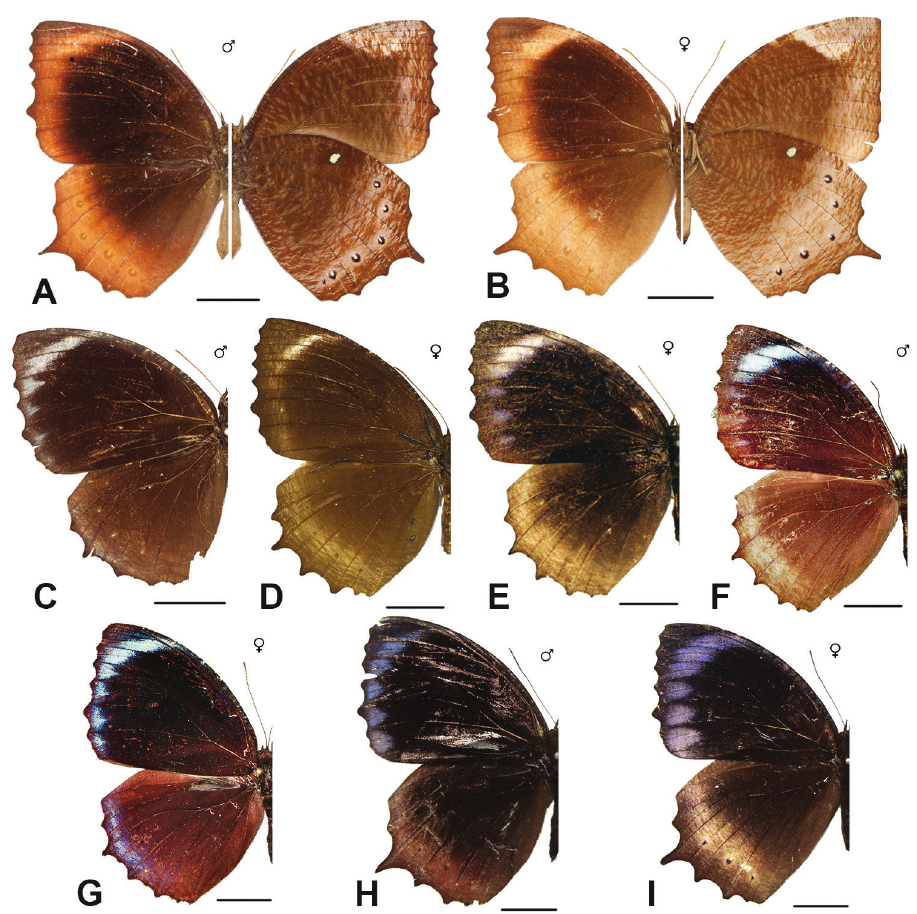
Figure 11. A obnubila ♂ D+V NHM Malaysia: Perak B obnubila ♀ D+V NHM Thailand: Ranong C congruens congruens ♂ D NHM Philippines: Cebu, Camotes Island D congruens subcongruens ♀ D NHM Philippines: Mindoro E congruens endida ♂ D SMFD Philippines: Bohol F congruens endida ♀ D SMFD Philippines: Bohol G congruens congruens ♀ D NMNH Philippines: Mindanao, Davao H miyagawai ♂ D SPC Vietnam: Lam Dong, Loc Bao; Holotype I miyagawai ♀ D SPC Vietnam: Lam Dong, Loc Bao; Paratype